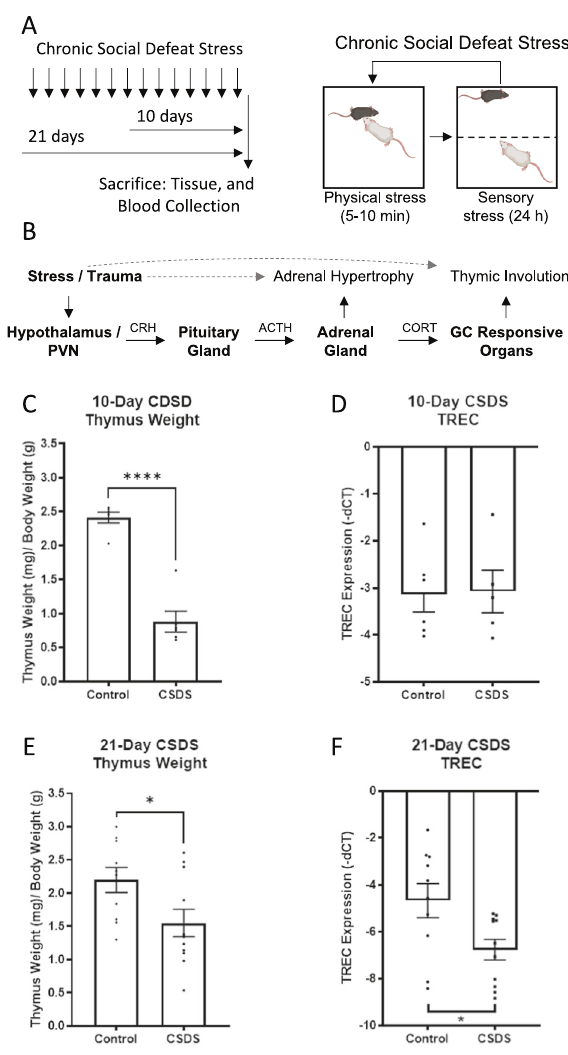
Fig. 1 Chronic Social Defeat Stress (CSDS) effects on adrenal gland, thymus, and TREC levels in male mice. A Simpli fi ed schematic of the 10-day and 21-day CSDS regimens. B Simpli fi ed schematic of HPA axis activation and resulting adrenal hypertrophy and thymic involution. C The 10-day CSDS regimen led to thymic involution, indicated by decreased thymus weight, but D it did not affect TREC levels in whole blood. In contrast, E the 21-day CSDS regimen led to thymic involution and F decreased TREC levels. Note that TREC data are depicted as -dCT to clarify that higher dCT integer values indicate lower levels of TRECs. * p < 0.05, ** p < 0.01, **** p < 0.0001, N ’ s = 6 – 11/group.